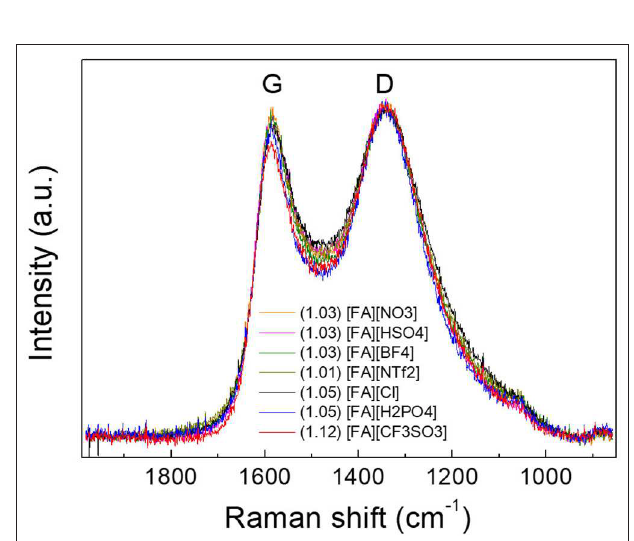
FIGURE 3 | Raman spectra of carbons derived from [FA][X]. The number in the parentheses is the I D / I G ratio.